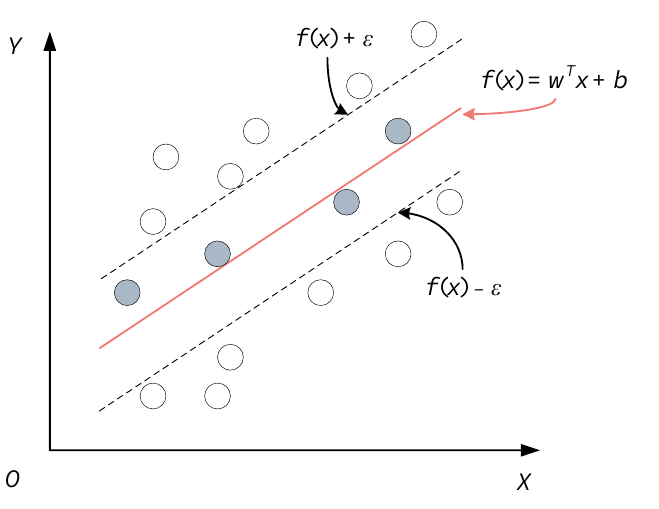
Figure 3. Schematic diagram of SVR.